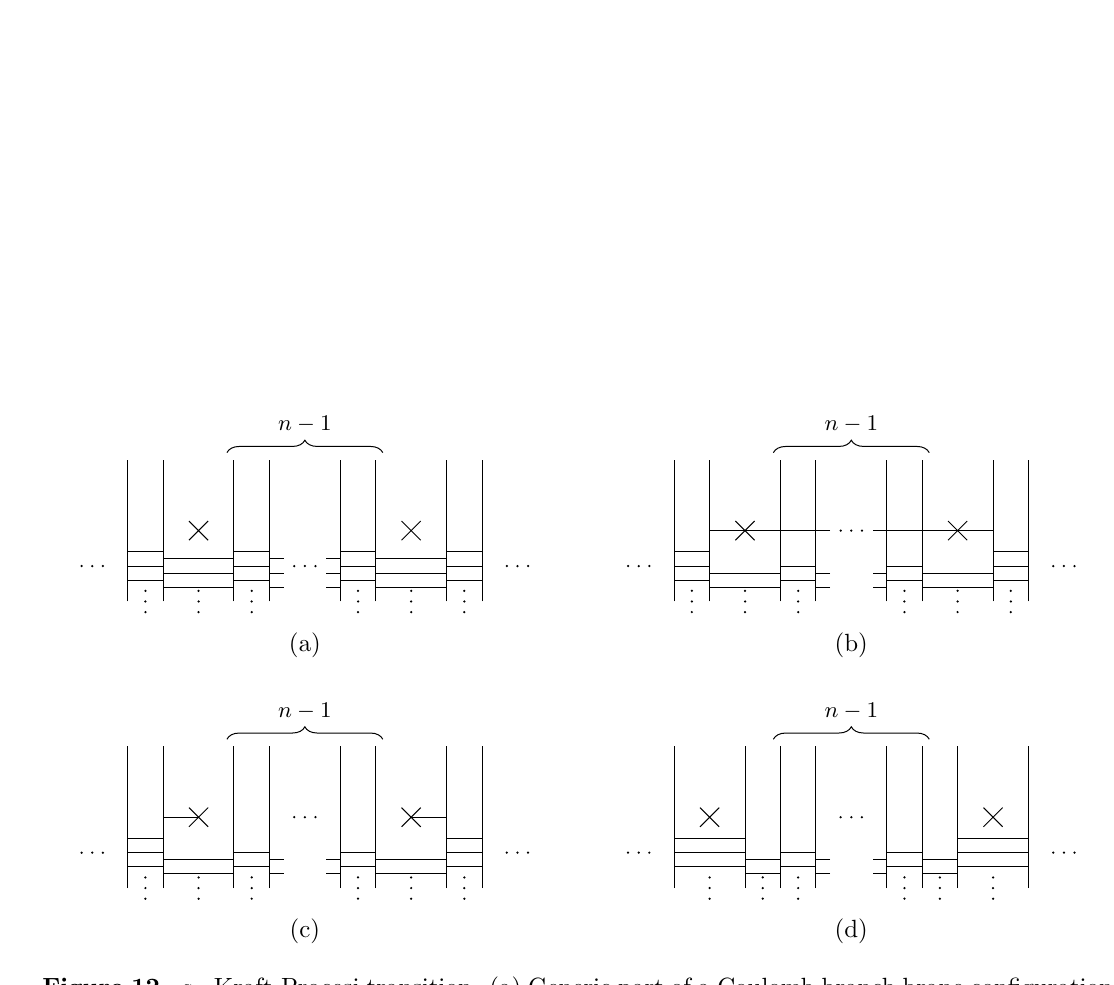
Figure 12. a n Kraft-Procesi transition. (a) Generic part of a Coulomb branch brane con(cid:12)guration with moduli space M C . The curly brace indicates the presence of n (cid:0) 1 NS5-branes in the middle, creating n (cid:0) 2 interval with no D5-branes in them. The moduli space generated by one D3-brane in each of the n middle intervals is the variety S = a n , i.e. it is isomorphic to the Higgs branch of 3 d N = 4 SQED with n + 1 (cid:13)avors. (b) The n relevant D3-branes are taken to the singular point ~x i = ~m j = (0 ; 0 ; 0). (c) The n D3-branes join and then split into three segments, one of them can acquire nonzero ~y position along the directions spanned by the D5-branes. One can take the limit when its ~y position goes to in(cid:12)nity, removing this brane from the system. This gives rise to a (cid:26) M C . (d) Two phase transitions have new brane con(cid:12)guration with a new Coulomb branch M 0 C been performed to annihilate the (cid:12)xed D3-brane segments and obtain a Coulomb branch brane con(cid:12)guration where the corresponding new quiver can be